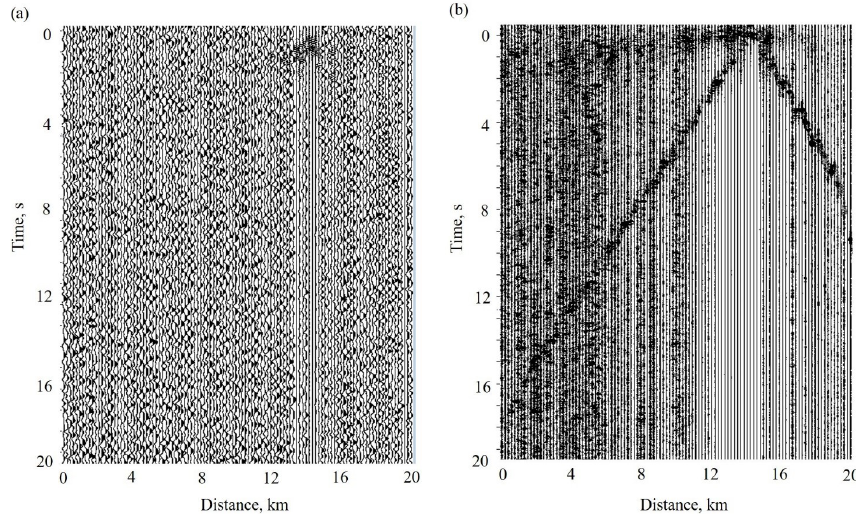
Figure 15. Cross-correlation functions of signals produced by Vibroseis © with the data recorded by wireless equipment at large offsets in the frequency band of (a) 1–10Hz, amplitudes normalized at maximum of each trace; (b) 20–100Hz. The signal used for cross-correlation is shown in Fig. 16.